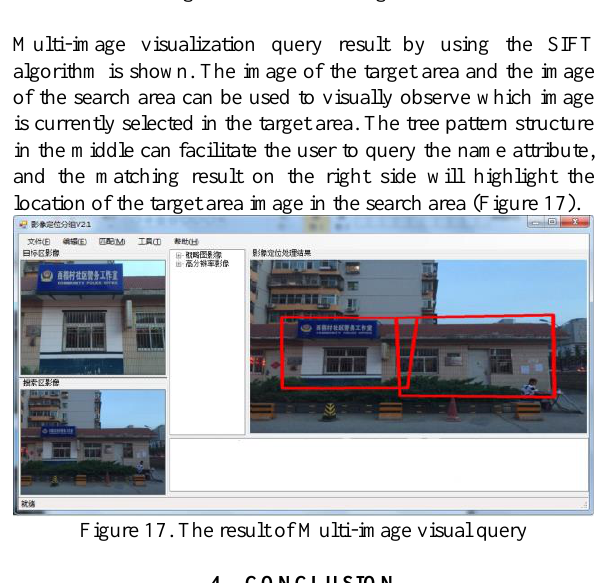
Figure 16. The matching result